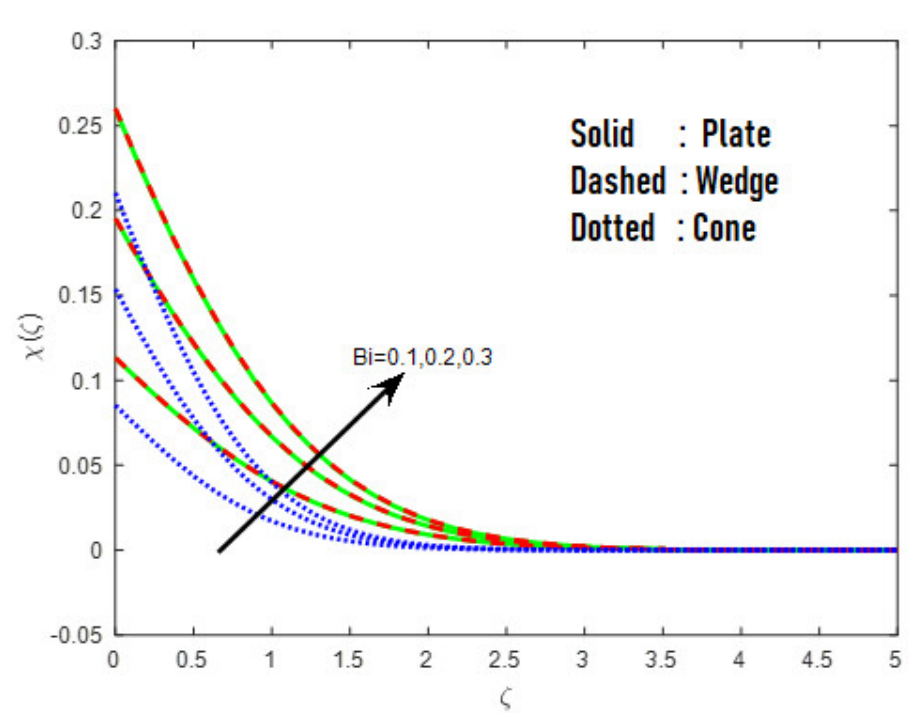
Figure 8.  vs.     . Figure 8. β vs. χ ( ζ )